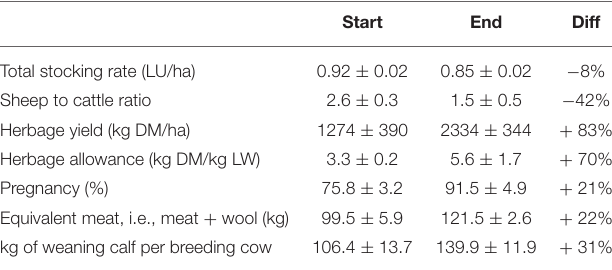
TABLE 2 | Average of the main productive variables of the seven pilot farms at the start (summer 2013) and end (2015) of the co-innovation process [adapted from Ruggia et al. (in